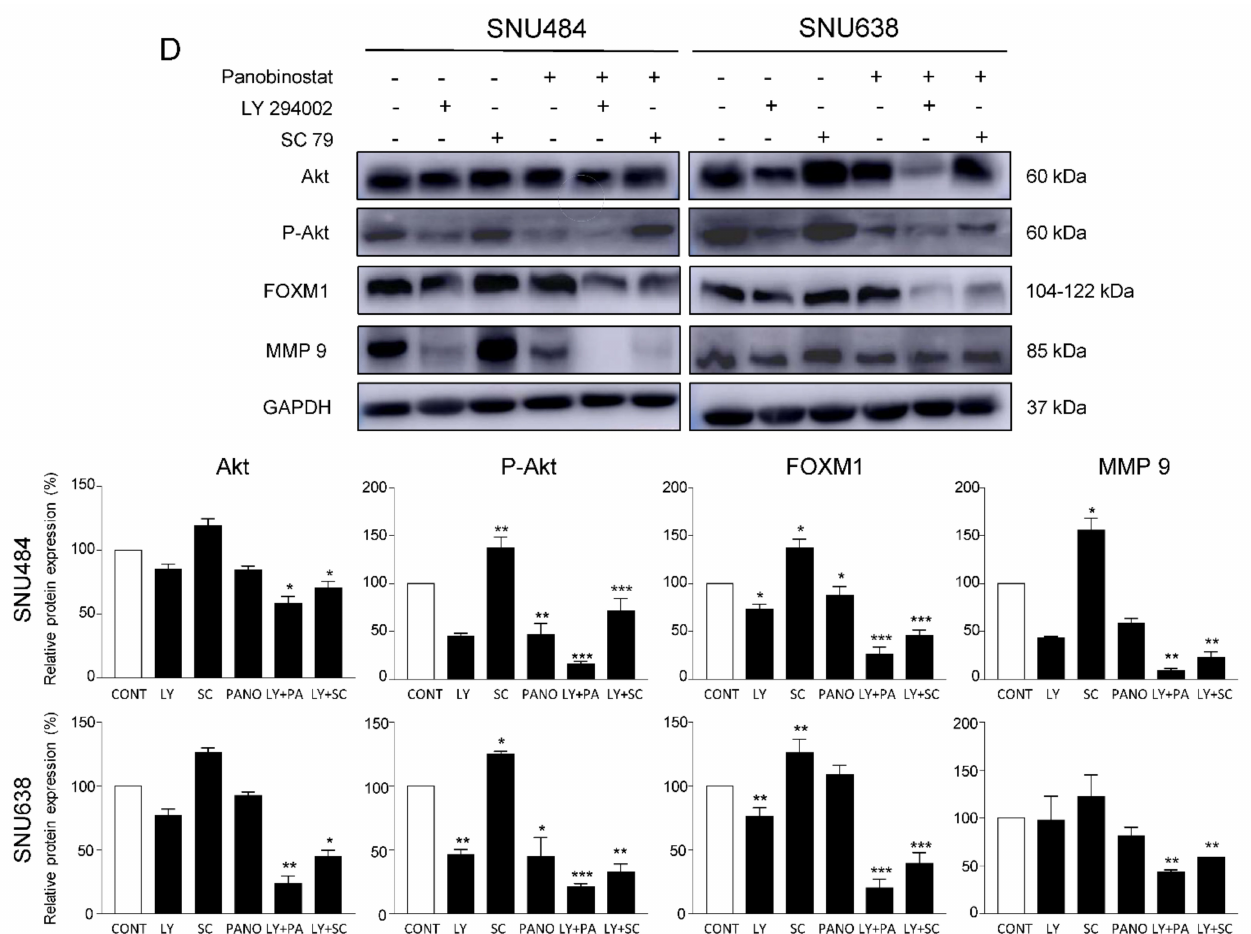
Figure 6. Panobinostat inactivates Akt/FOXM1 signaling in gastric cancer cells. SNU484 and SNU638 cells were treated with panobinostat (0, 10, 50, and 100 nM) for 48 h. ( A ) The expression levels of Akt, p-Akt, and FOXM1 were analyzed after treatment with panobinostat at different concentrations in SNU484 and SNU638 cells using Western blotting assays. GAPDH was used as an internal control. ( B ) Densitometric analysis result of p-Akt-to-Akt ratio from the Western blotting data shown in ( A ). The Western blot band intensity was quantitatively analyzed using ImageJ software (NIH, Bethesda, MD, USA). Data represent the mean ± SE of three independent experiments. * p < 0.05, ** p < 0.01, and *** p < 0.001 compared with the control. ( C ) The FOXM1 expression band intensity was quantitatively analyzed using ImageJ software. ( D ) Protein expression levels of Akt, p-Akt, FOXM1, and MMP-9 were detected by Western blot analysis after panobinostat treatment (50 nM) with Akt inhibitor (LY2940002) or Akt agonist (SC79). LY294002 (10 µ M) and SC79 (10 µ M) were pre-treated for 2 h and treated with panobinostat (50 nM) for 48 h. The Western blot band intensity was quantitatively analyzed using ImageJ software. Data represent the mean ± SE of three independent experiments. * p < 0.05, ** p < 0.01, and *** p < 0.001 compared with the